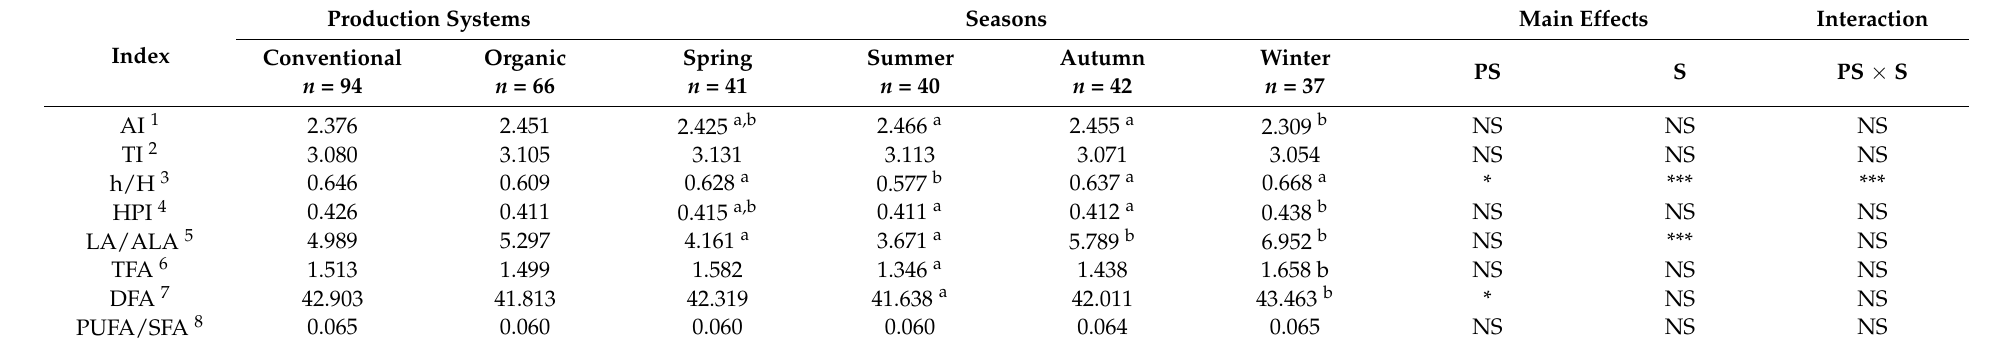
Table 6. Effects of production system and season on milk fat nutritional indices and p - values for the main effects and their